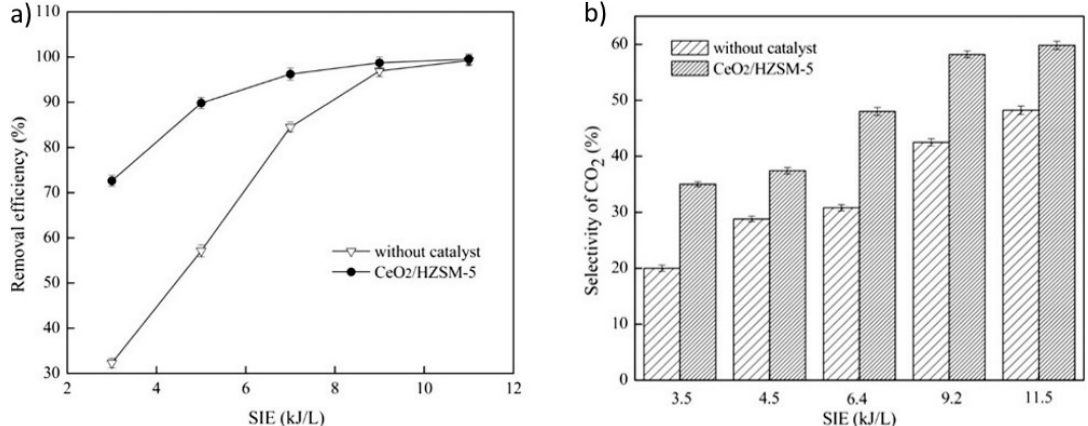
Figure 19. Influence of CeO 2 /HZSM-5 on ( a ) chlorobenzene removal efficiency and ( b ) selectivity of CO 2 . Reprinted from Reference [125], with permission from Elsevier.